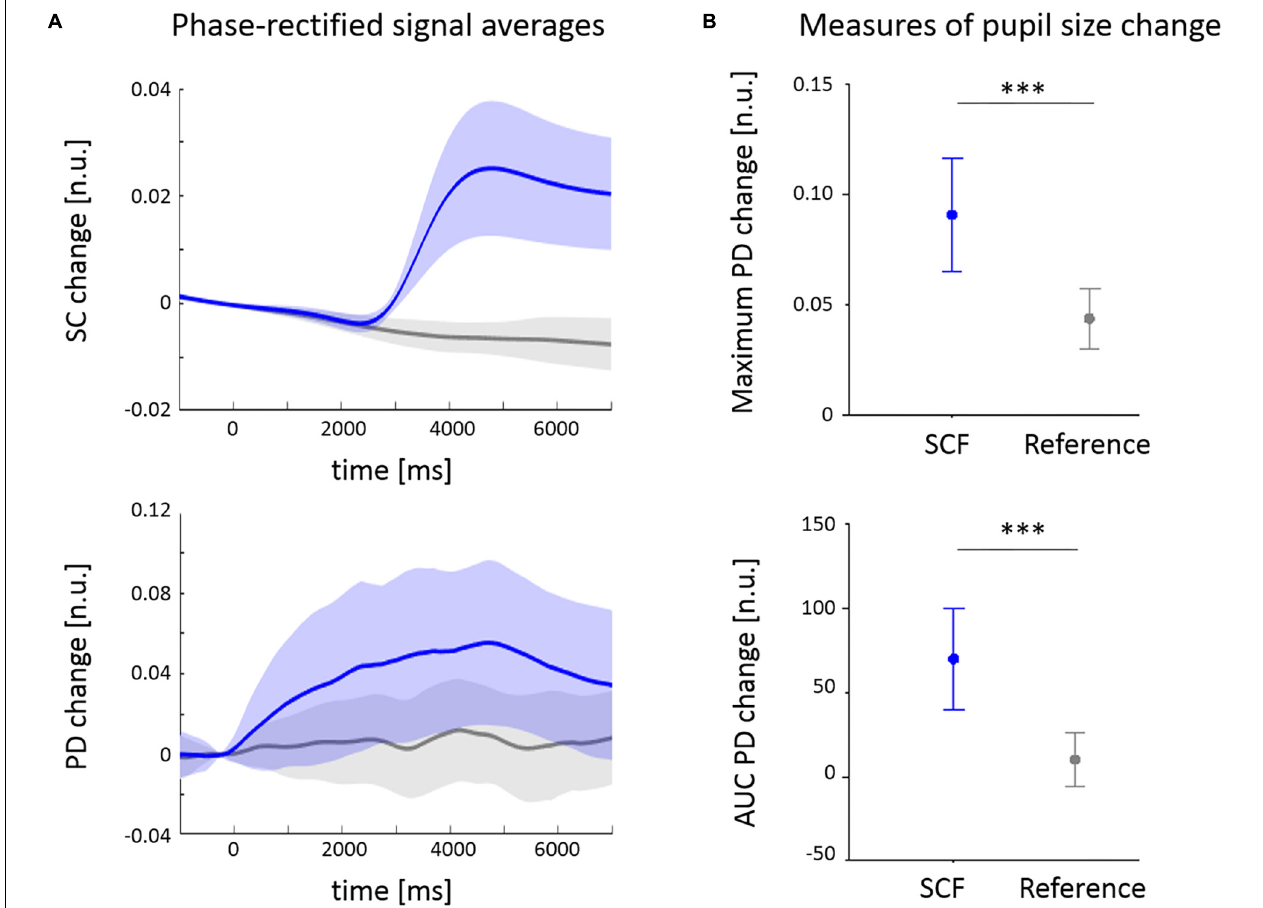
FIGURE 2 | Mean changes of pupil diameter (PD) in phase with fluctuations of skin conductance (SC). (A) Averaged change of pupil diameter (PD) normalized to a baseline 500 ms before the reference time point t = 0. (B) Averaged fluctuations of skin conductance (SCF) used as events to analyze PD reactions. Reference time point t = 0 was extracted 2500 ms prior to each SCF onset. SC changes were normalized to a baseline 500 ms before the reference time point. ∗∗∗ p <